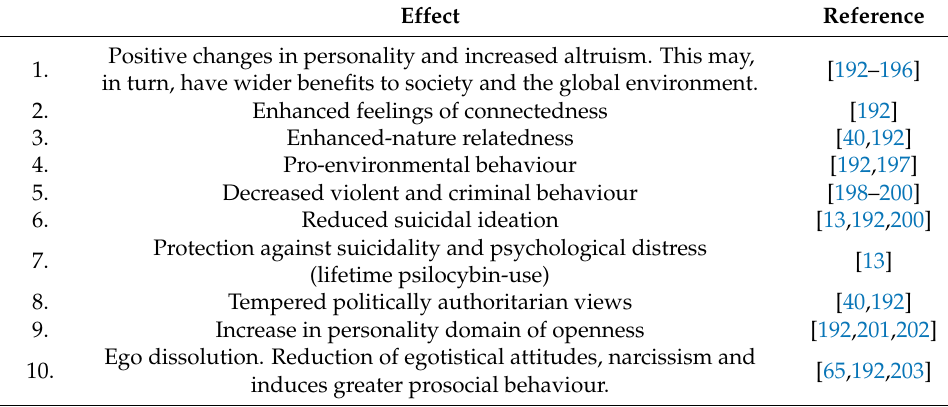
Table 4. Additional acute and long-term subjective effects of psilocybin